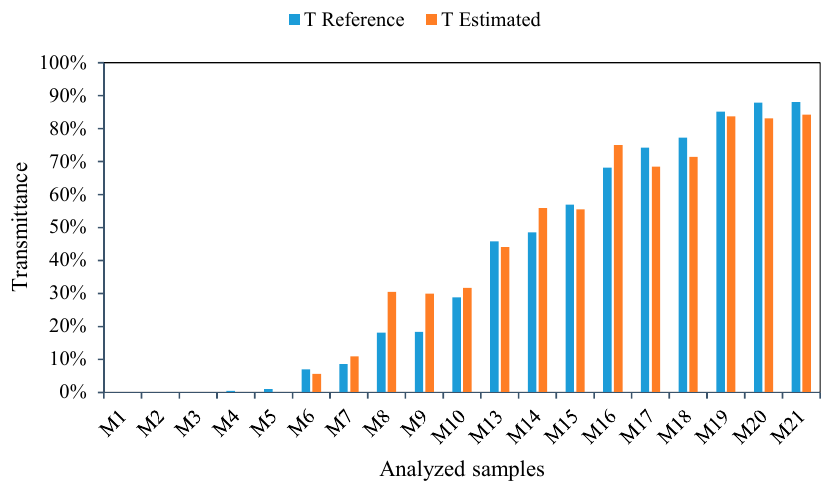
Figure 14. Comparison of calibration equations for 450 nm wavelength. Table 2. 445 nm fit quality comparison using di ff erent